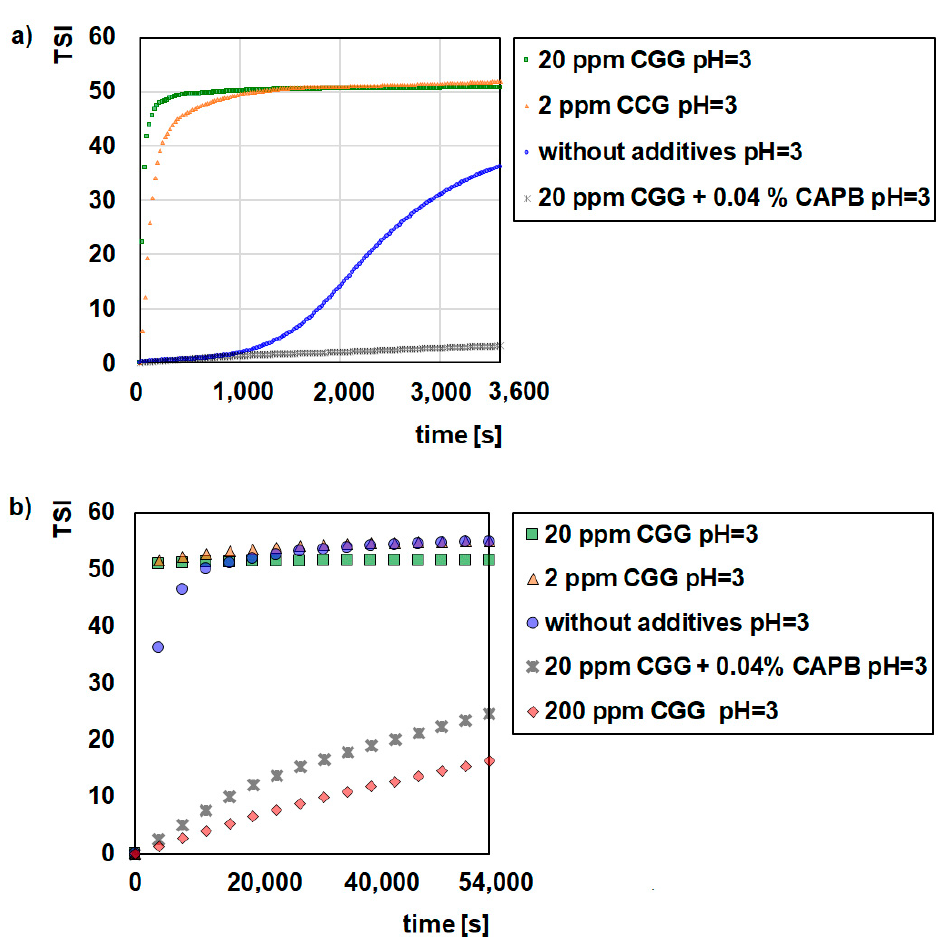
Figure 1. Influence of CGG with the addition of 0.04% CAPB on stability of the glauconite suspensions at pH = 3; 1 h ( a ), 15 h ( b ).